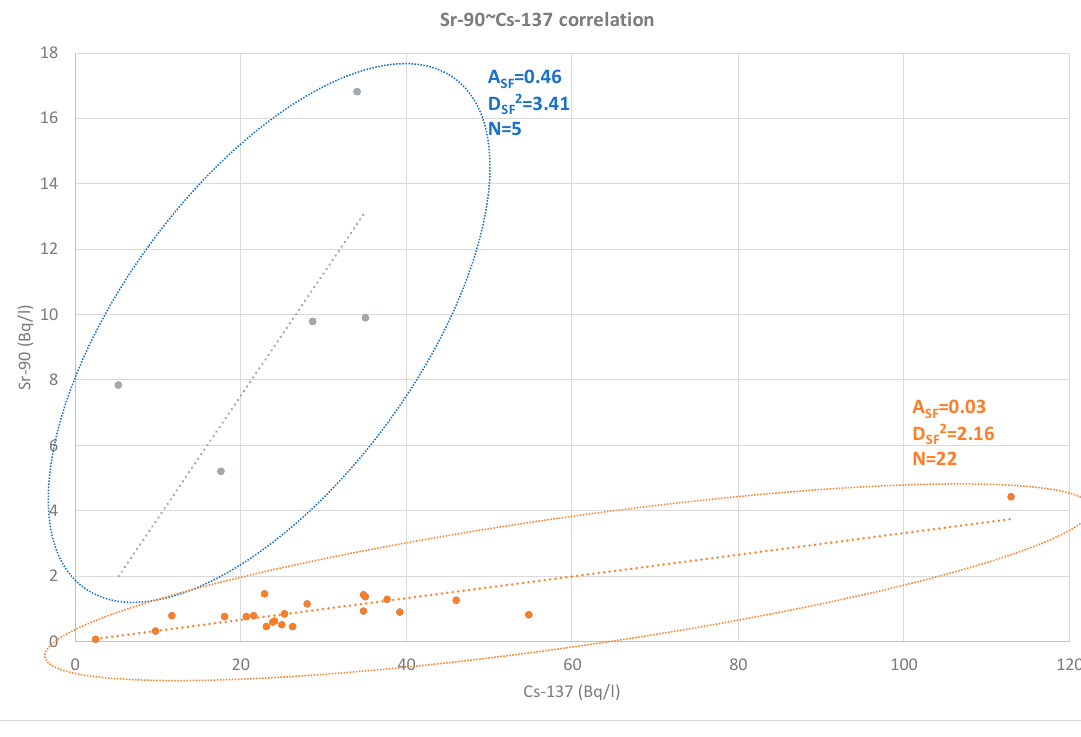
Figure 5. Sr-90~Cs-137 correlation in the Trino “E. Fermi” nuclear power plant’s liquid e ffl uents—identified groupings have been